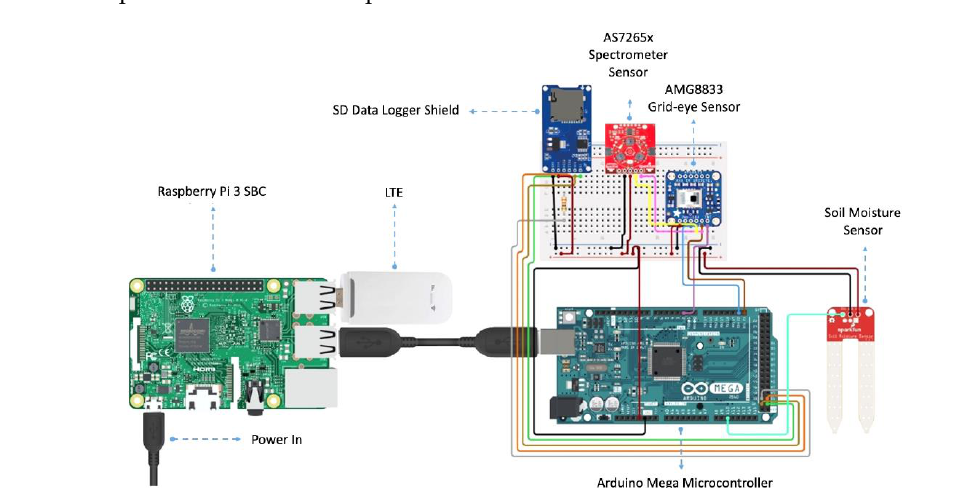
Figure 2. Plant observation component